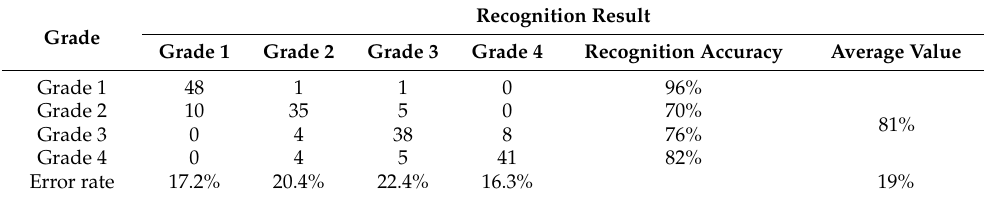
Table 3. Recognition accuracy and error rate of the system under static conditions.